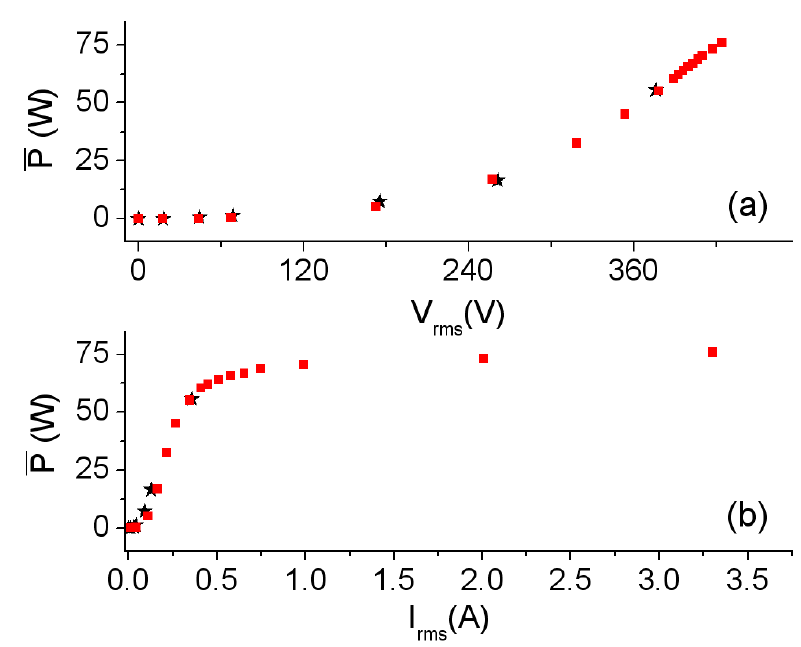
Figure 7. Results at 40 kHz. ( a ) P - V simulation ( – ■ –